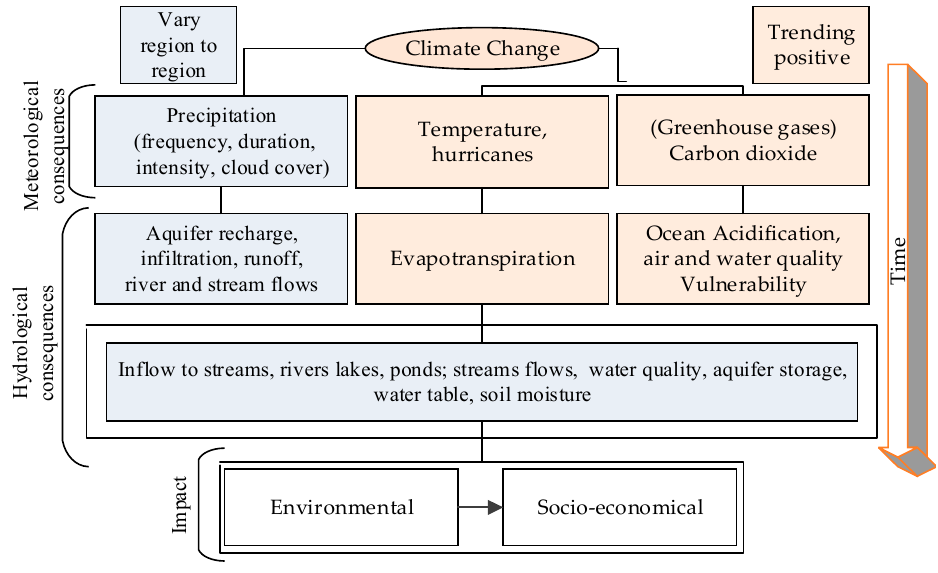
Figure 8. Conceptual framework showing relative variations among hydrological and climatological variables in the climate change scenario with respect to an increase in time.